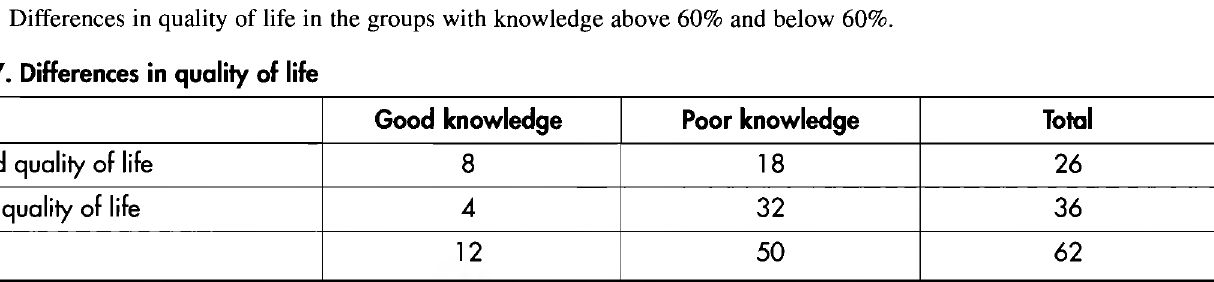
Table 7: Differences in quality of life in the groups with knowledge above 60% and below 60%. TABLE 7. Differences in quality of